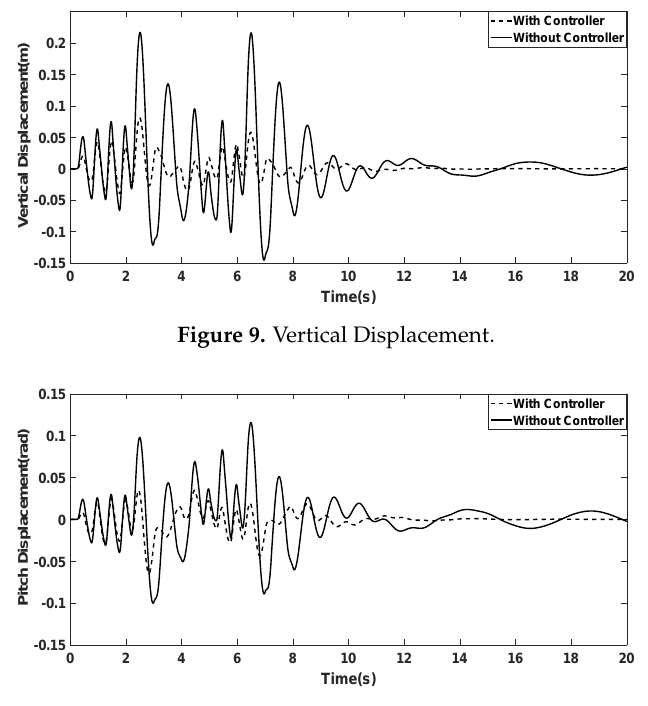
Figure 10. Pitch